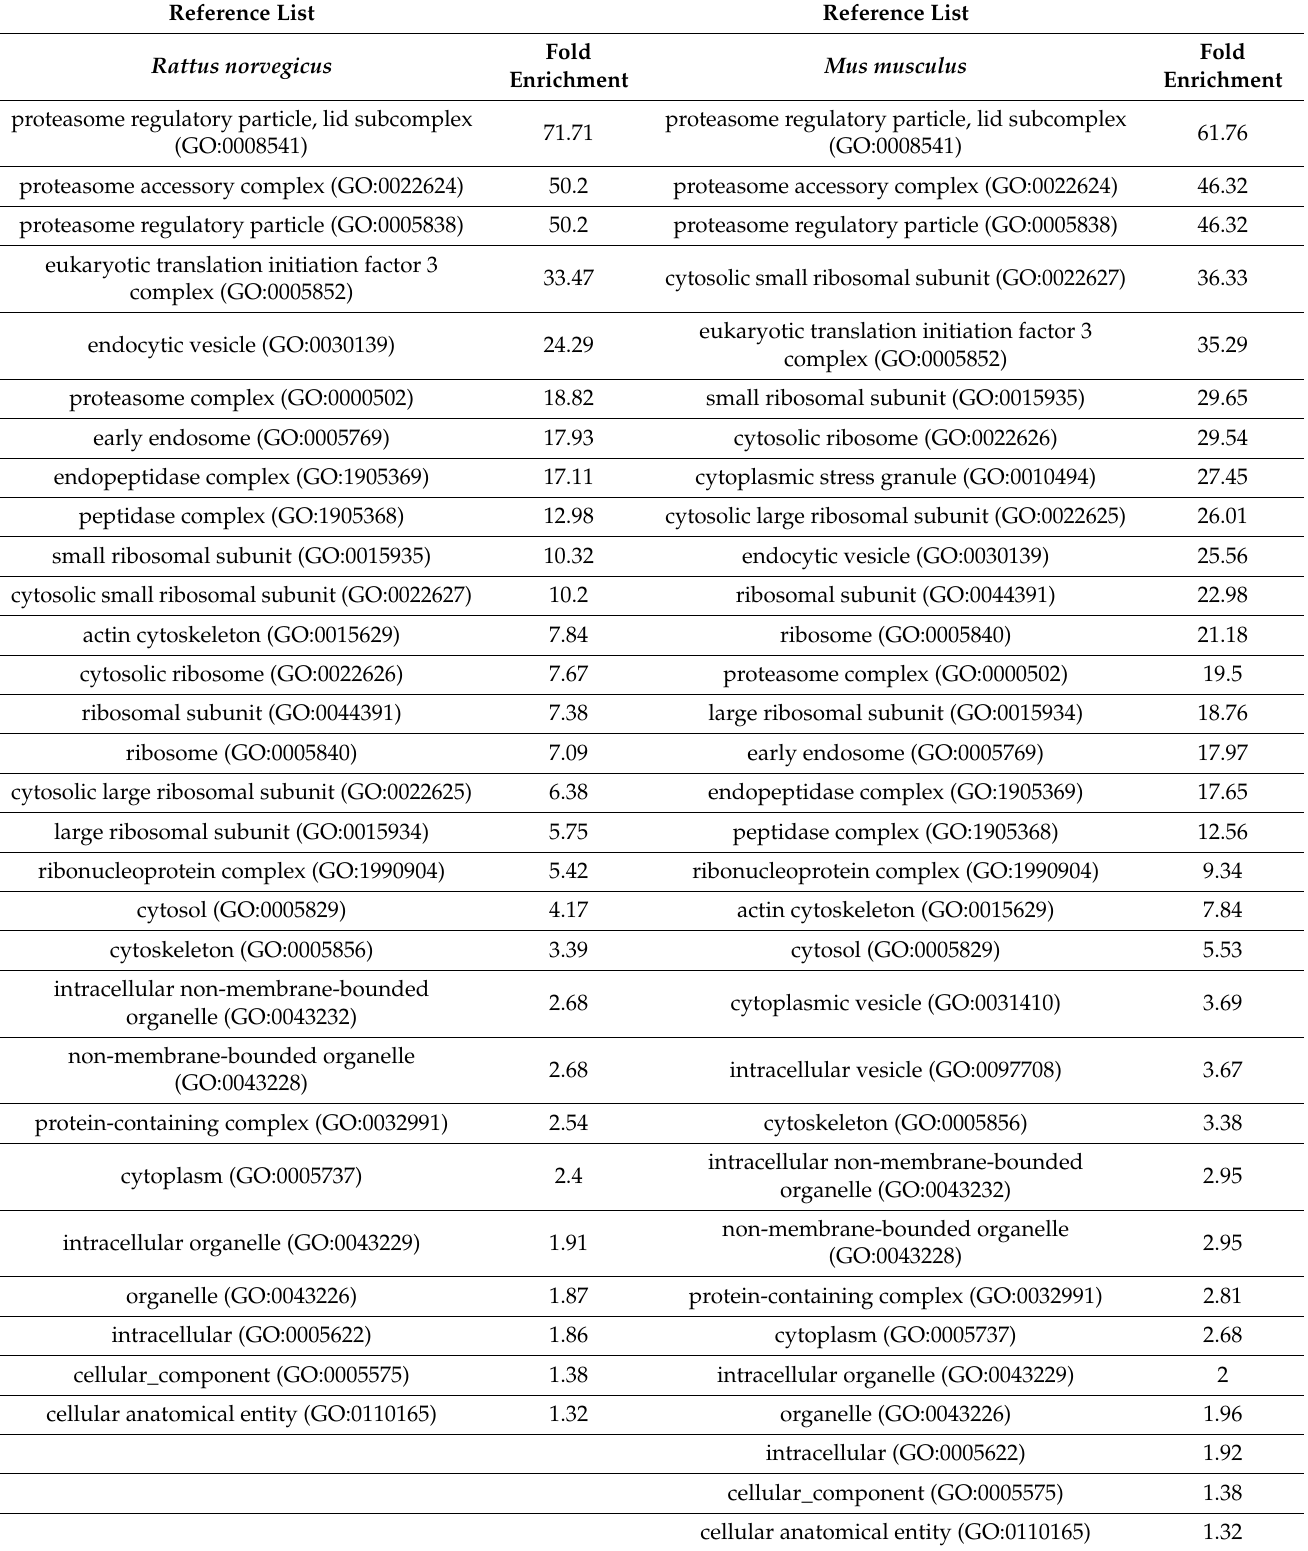
Table 5. PANTHER GO-Slim Cellular Component